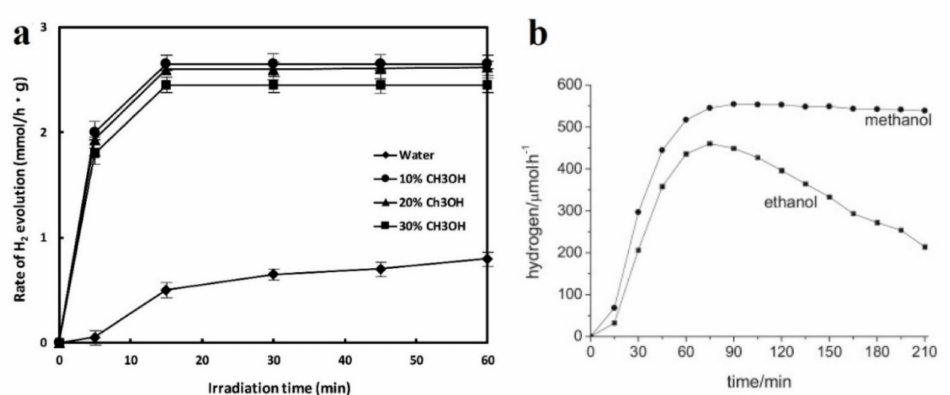
Figure 4. ( a ) Rate of hydrogen evolution from photocatalysis of aqueous methanol solution on Ag / TiO 2 photocatalysts. This figure is reprinted from [60], with permission from Elsevier, 2020; ( b ) H 2 production patterns for 24.47 M (100% v / v ) of methanol and 17.06 M (100% v / v ) of ethanol. This figure is reprinted from [54], with permission from Elsevier,